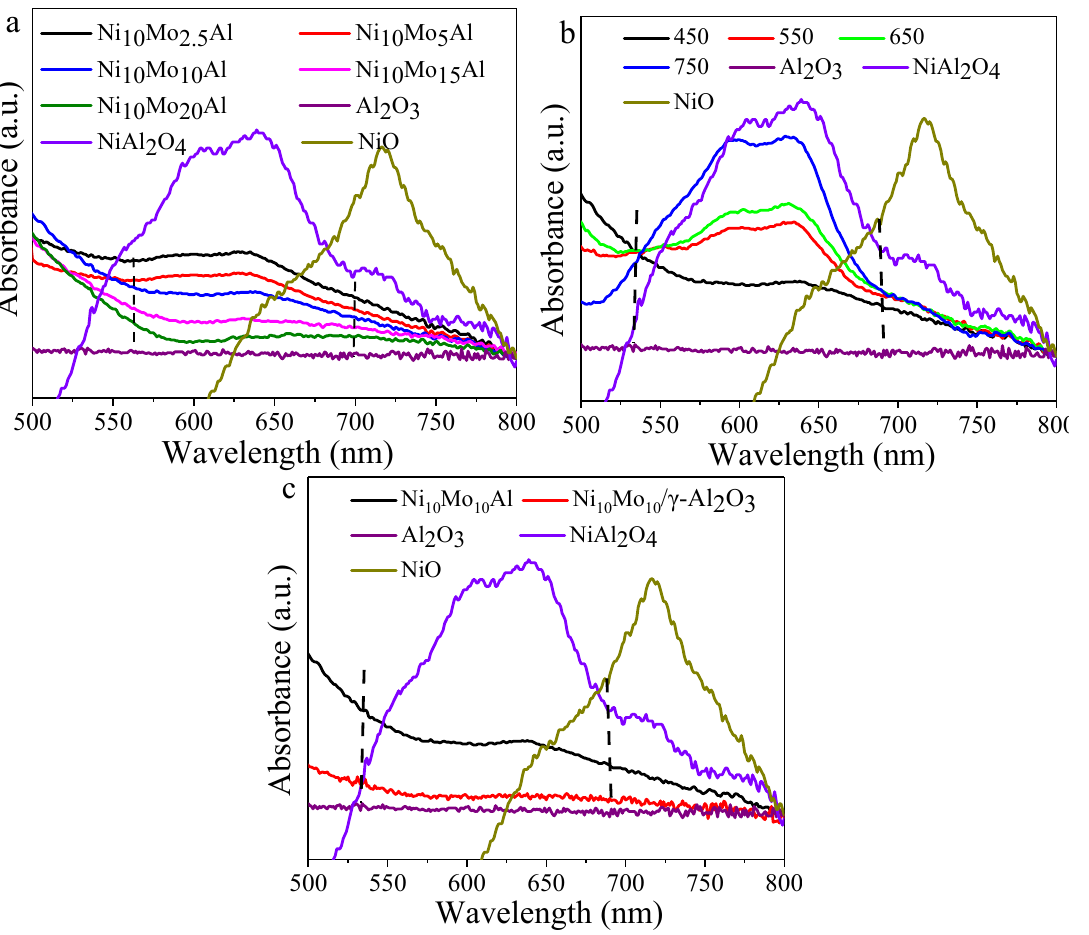
Figure 7. UV-vis DRS spectra of ( a ) Ni 10 Mo x Al catalysts, ( b ) Ni 10 Mo 10 Al catalysts calcined at 450–750 °C and ( c ) Ni 10 Mo 10 Al and Ni 10 Mo 10 / γ -Al 2 O 3 catalysts calcined at 450 °C.